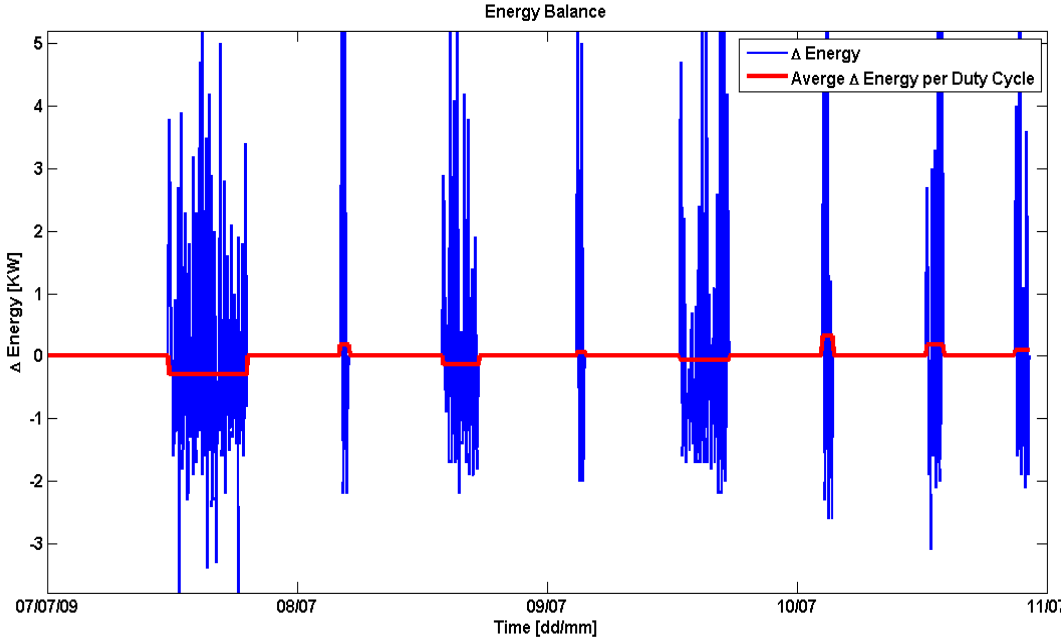
Figure 13. Energy flux balance in an adsorption chiller.